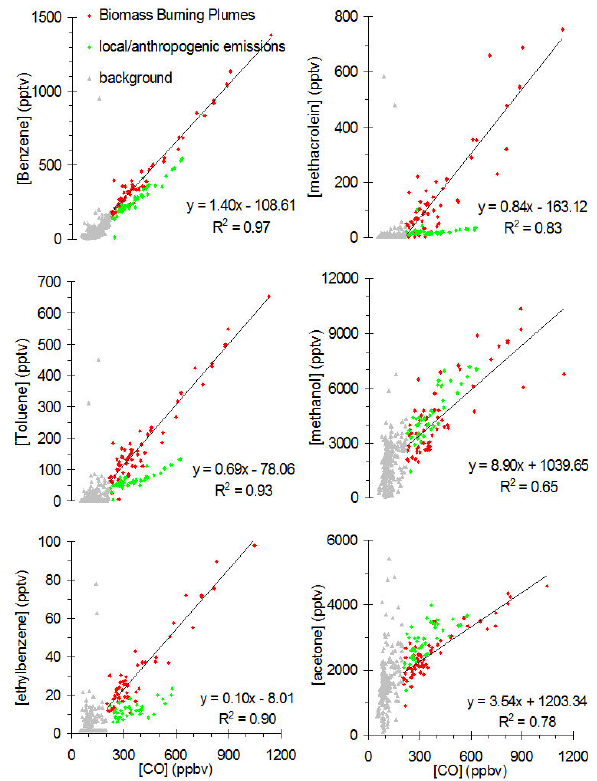
Fig. 2b. Selected plots of alkenes vs. CO. Grey triangle assigned as background air, red diamonds assigned as biomass plumes and green diamonds assigned as anthropogenic plumes.